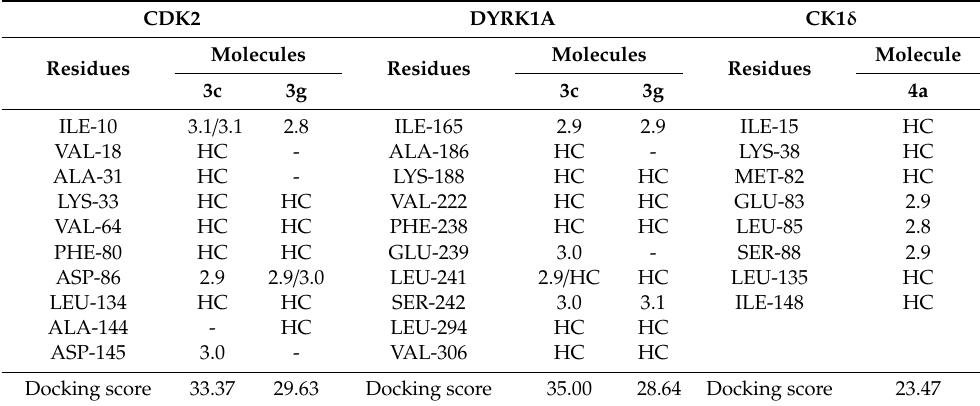
Figure 1. Detailed view of the docking pose for ( A ) compound 3c and ( B ) compound 3g , regarding the target CDK2. Residues involved in hydrophobic interactions (green), hydrogen bonds (colored per element with carbon atoms in cyan) are highlighted. Table 4. Molecular interaction of CDK2 and DYRK1A with molecules 3c and 3g , and CK1 δ with molecule 4a